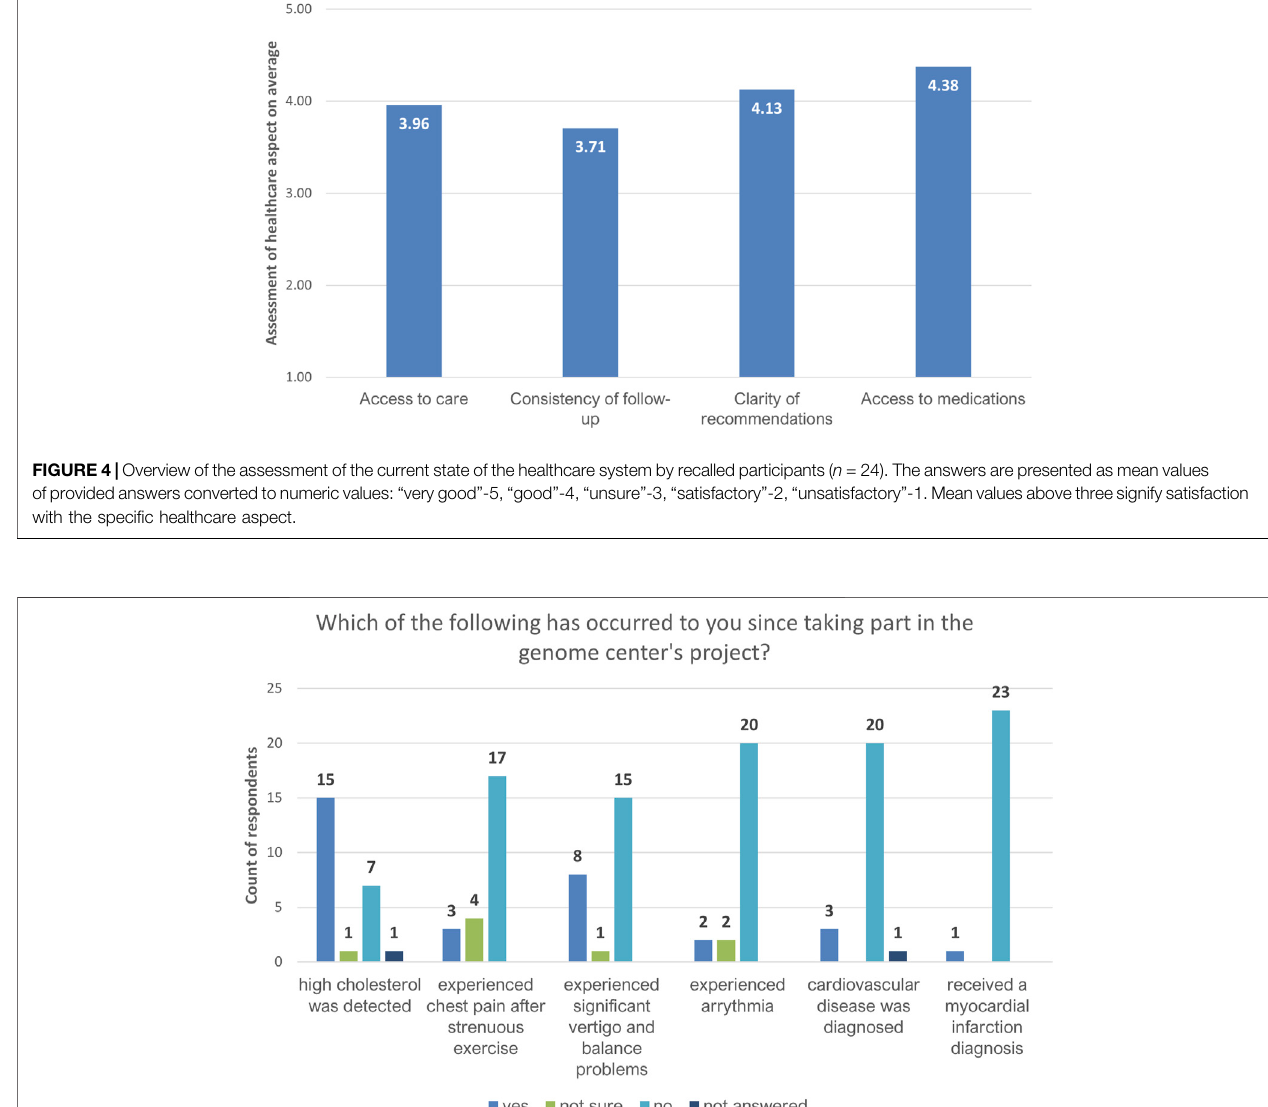
( Figure 7 ). Responses to questions about changes in participants ’ smoking habits and physical activity levels, and with whom they had shared information about their carrier status, are summarized in Supplementary Figures S2 – S4 .